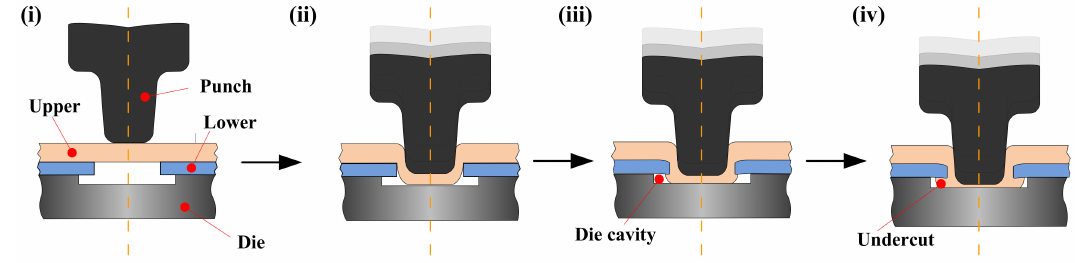
Figure 1. Schematic of the hole-clinching